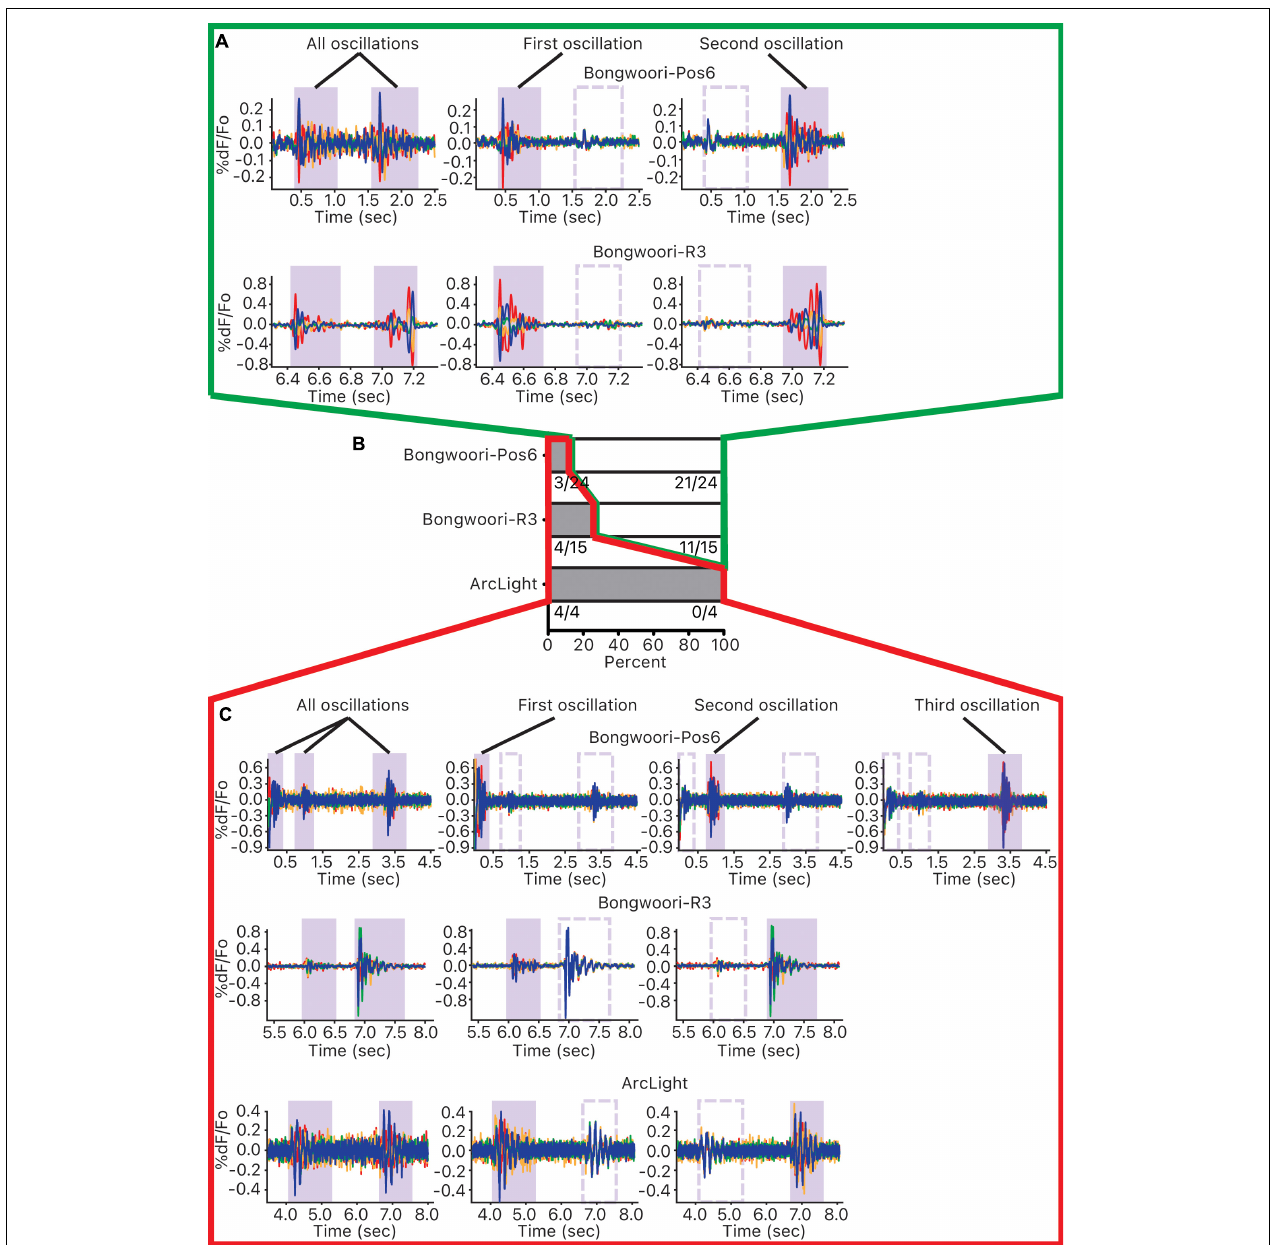
FIGURE 6 | Investigating common neural substrates of oscillations. For each 10 s recording containing more than one oscillation, pairwise correlations of each unmasked pixel and the reference pixel were calculated. Pixels were ordered and grouped into four groups according to the strength of their correlations. This correlation was first performed over all the oscillations, and then each of the oscillations occurring during the 10 s recording. (A) Pixels that were correlated for one oscillation but not the other indicate that the pixels that oscillated together for one oscillation did not oscillate together for the other one. (B) For each GEVI, distribution of oscillation pairs that mostly shared oscillating pixels (gray, outlined in red) and oscillation pairs that mostly did not share oscillating pixels (white, outlined in green). (C) Pixels that were correlated for one oscillation as well as for the other indicate that the pixels that oscillated together for one oscillation oscillated together for the other